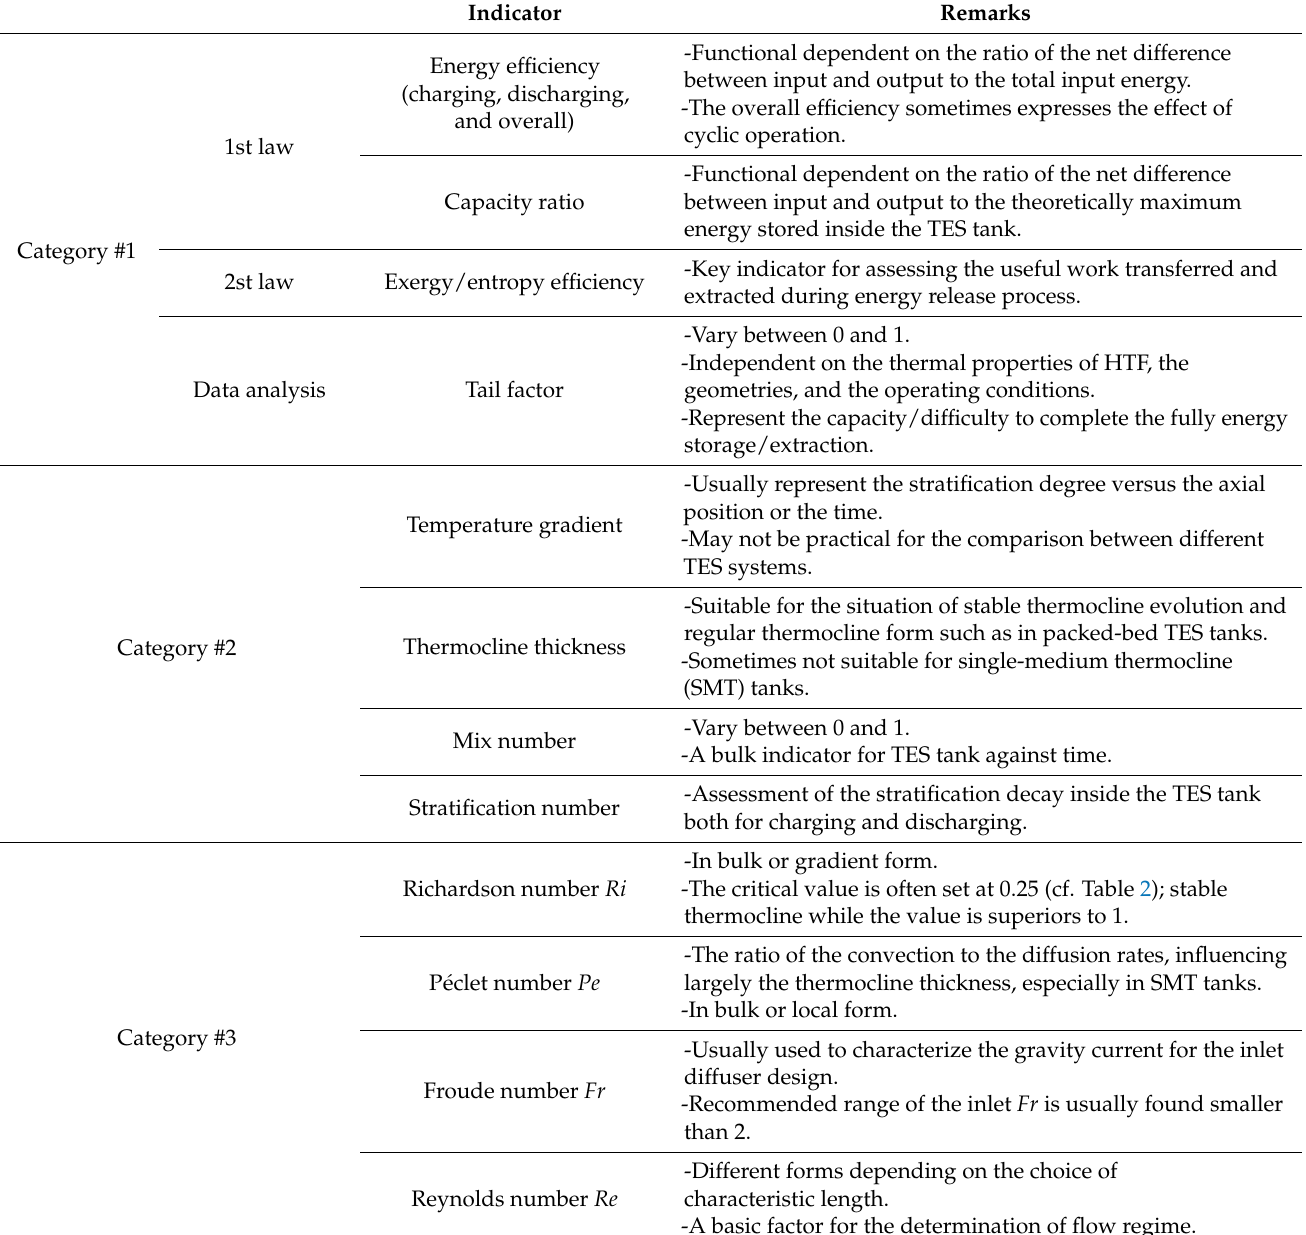
Table 1. Summary of common performance indicators for thermocline TES